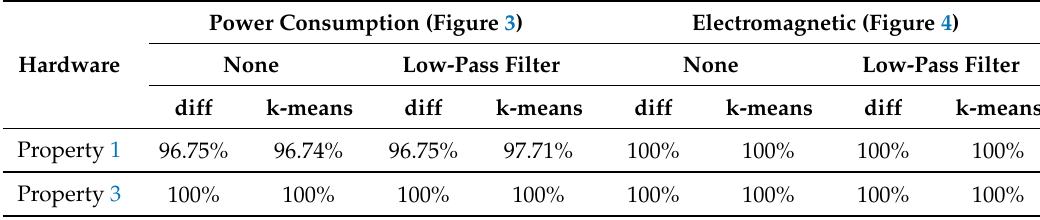
Table 1. Experimental results: hardware implementations.